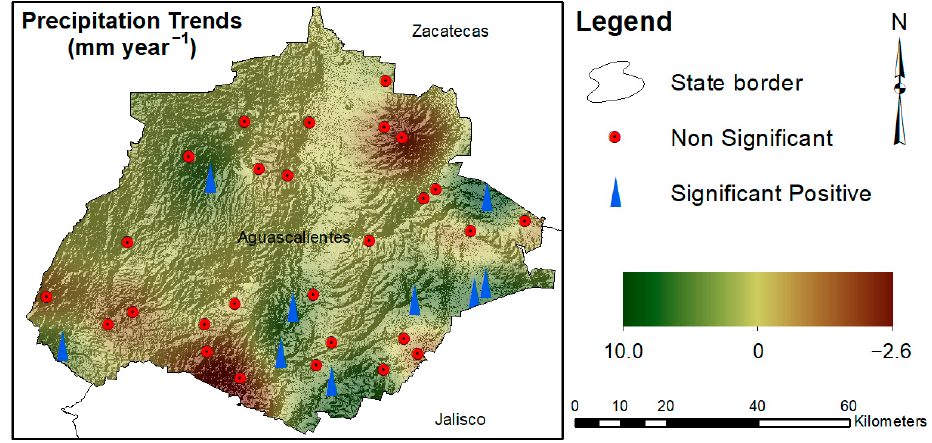
Figure 6. Spatial variation of the annual precipitation trend in Aguascalientes.